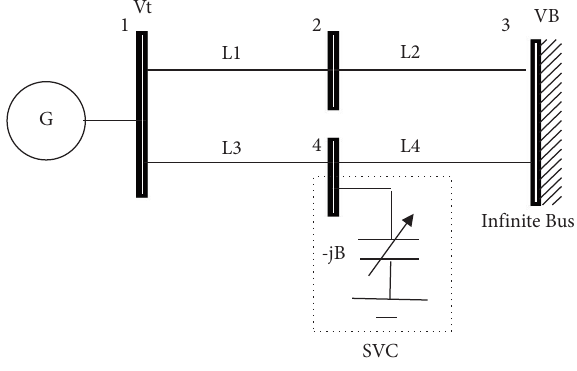
Figure 2: Studied power system.